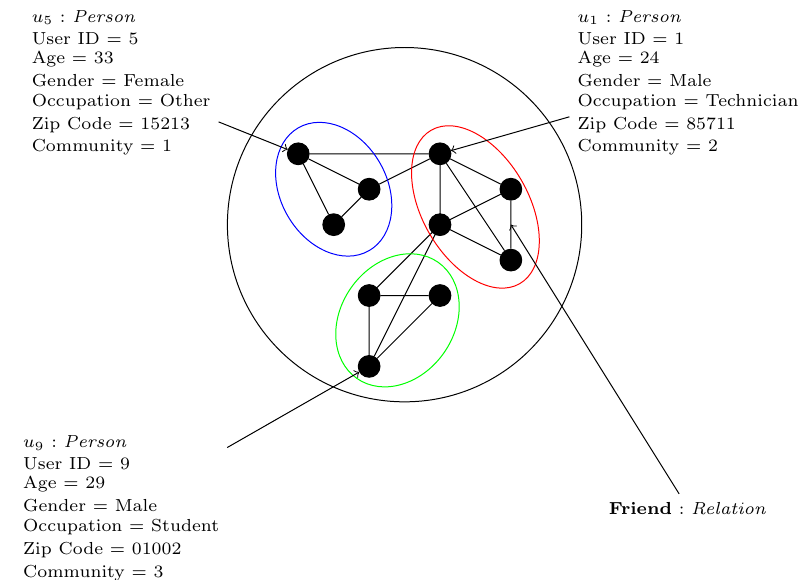
Fig. 5. (Color online) Graph Data Model. The social graph contains three communities represented by green, red, and blue ellipses. Each user of a community is characterized by her user id, age, gender, occupation, zip code, and community. The edges among the nodes represent a